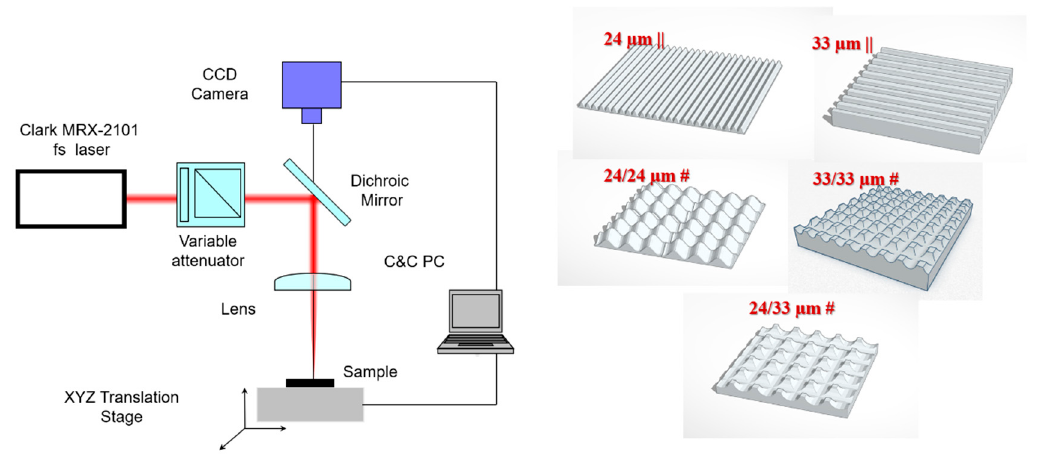
Figure 1. Experimental set-up, the Zirconia control, and the proposed textured designs .